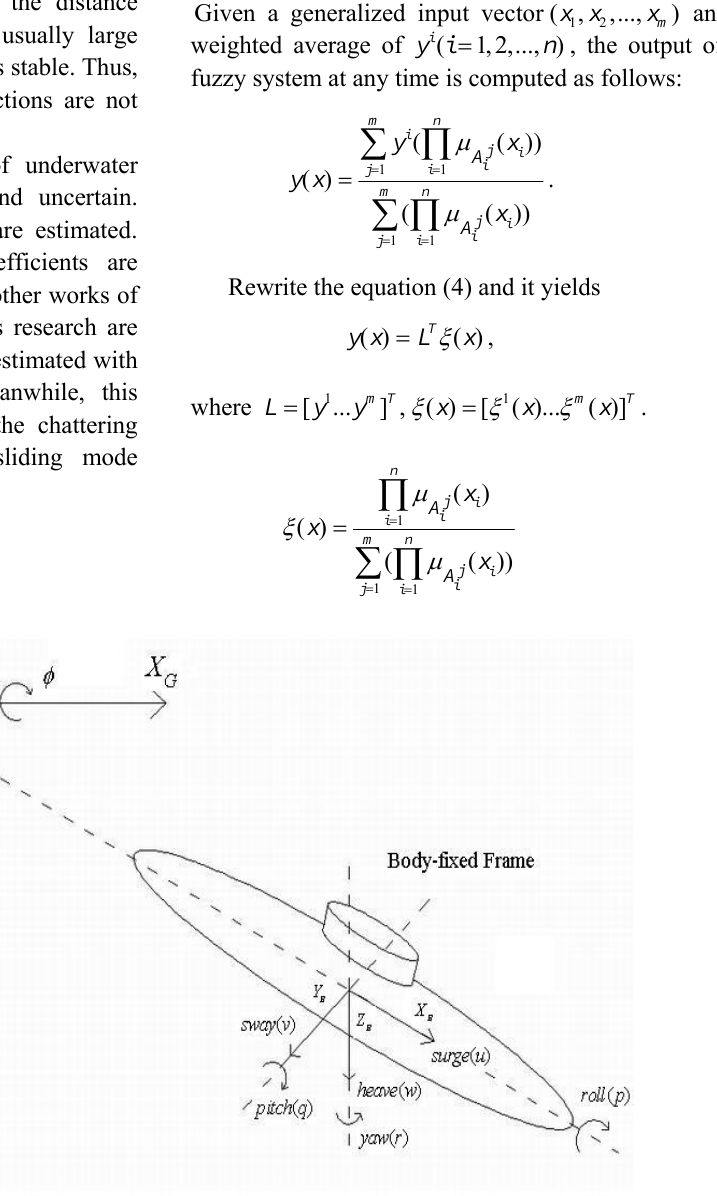
Fig. 1. Frames and variables of underwater